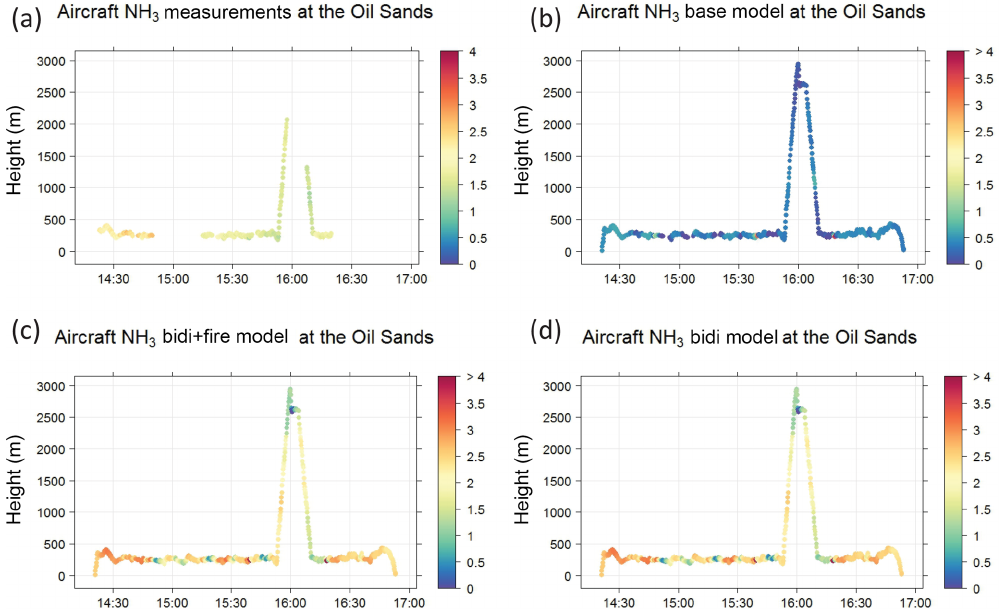
Figure 7. NH 3 VMRs aloft (colour scale) over the oil sands region during the 13 August 2013 flight. (a) Measurements, (b) base model, (c) fire + bidi model, and (d) bidi model.